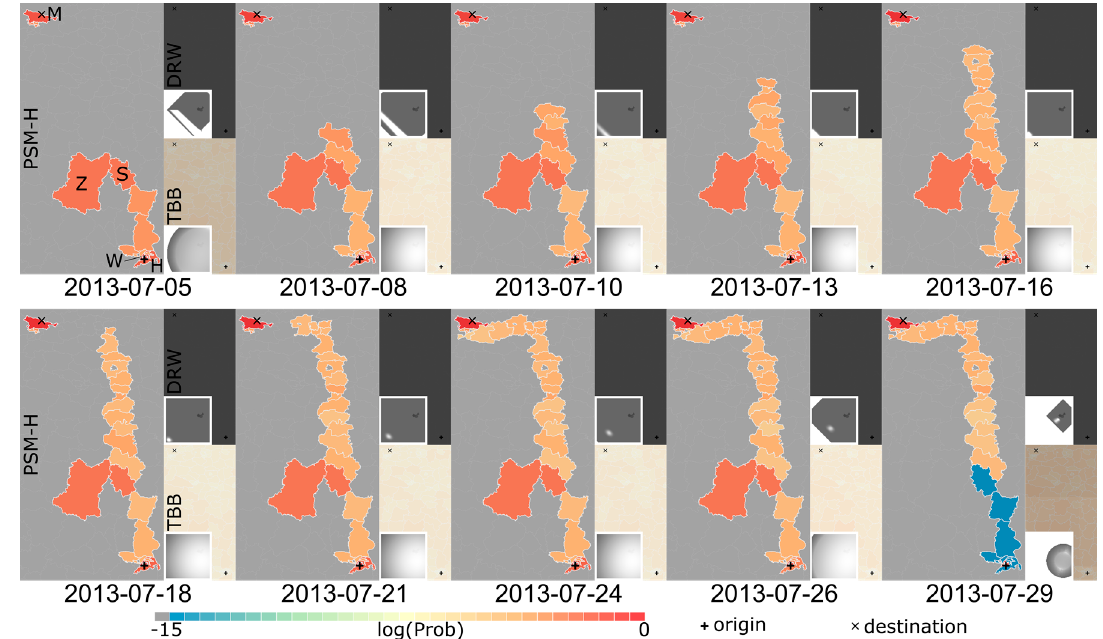
Figure 4. The visit probability distributions by four models during a long trajectory gap involving a regional trip. The extent of each snapshot is 30.27N to 35.08N, and 112.15E to 114.70E, while that of each inset is 85.06S to 85.06N, and 180.0W to 180.0E.